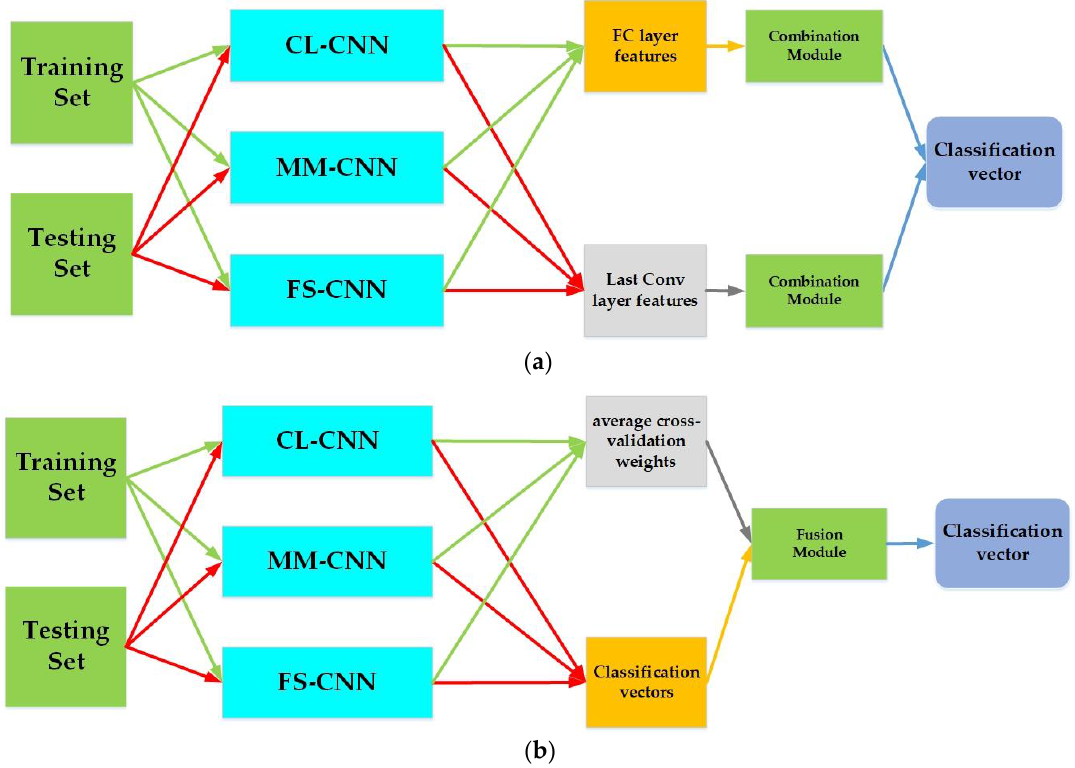
Figure 3. Final classification vector based on the three CNN architectures ( a ). Feature combination of the three CNN architectures ( b ) Fusion of the three CNN architectures.